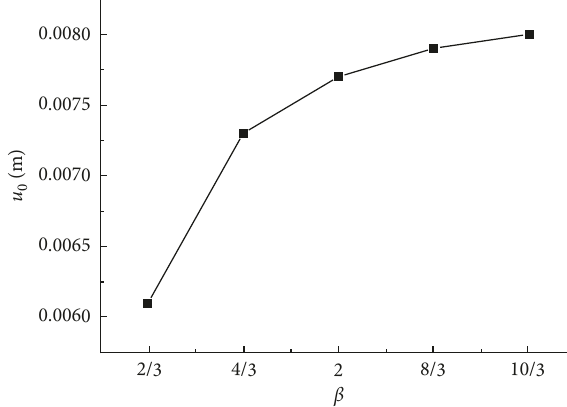
Figure 13: The values of u